Question: What does this figure show? Answer in one sentence.
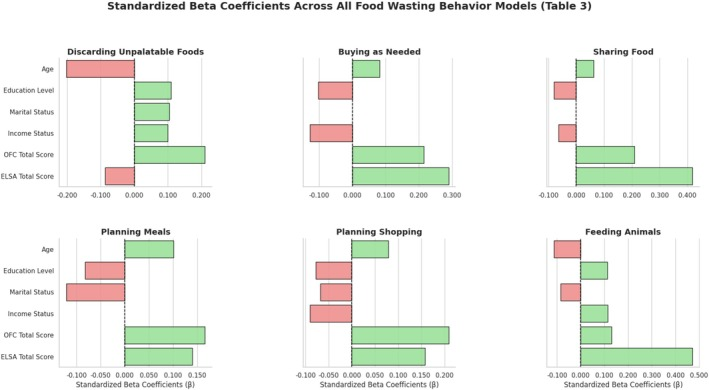
Answer: Standardized beta coefficients from multiple linear regression models predicting six sub‐dimensions of food wasting behaviors ( N = 1025). Green bars indicate positive predictors, while red bars indicate negative predictors. Independent variables include age, education level, marital status, income status, and total scores from the OFC and ELSA. All values are reported to three decimal places ( p < 0.05 for all highlighted variables).